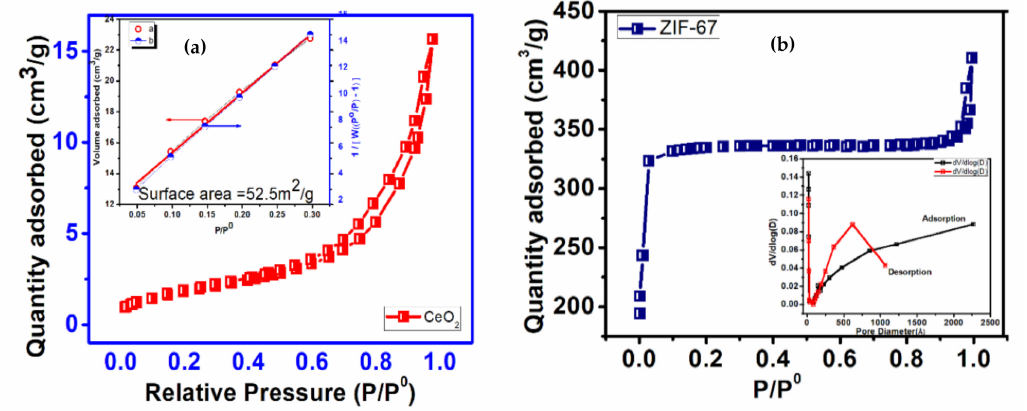
Figure 6. N 2 adsorption–desorption isotherms of ( a ) Pure CeO 2 , and ( b ) ZIF-67.